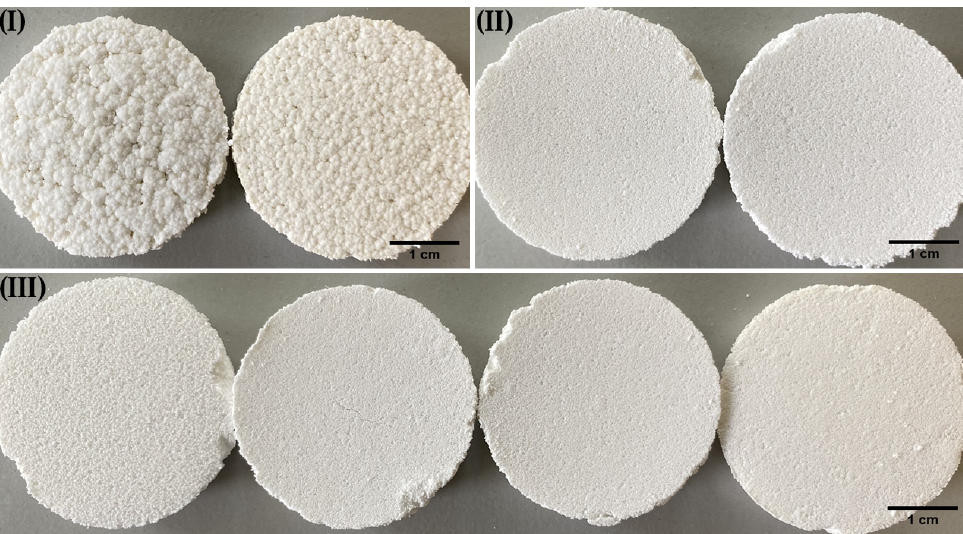
Figure 7. Surfaces of the briquettes with 60% ratio lac and 30% ω wet . Left to right: ( I ) Lac H and